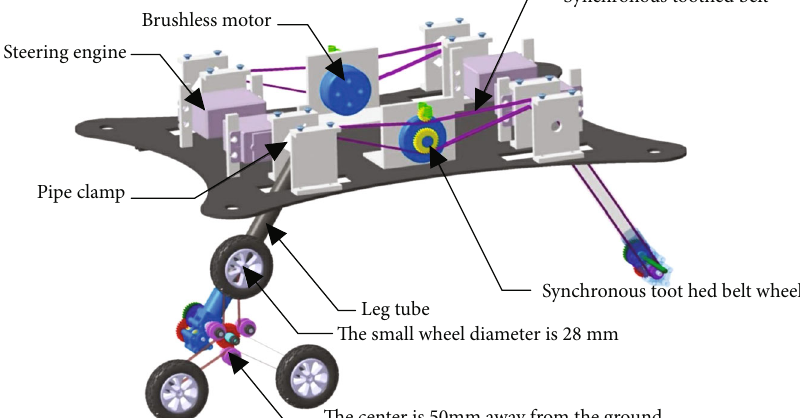
Figure 2: Main body of the speci fi c structure.